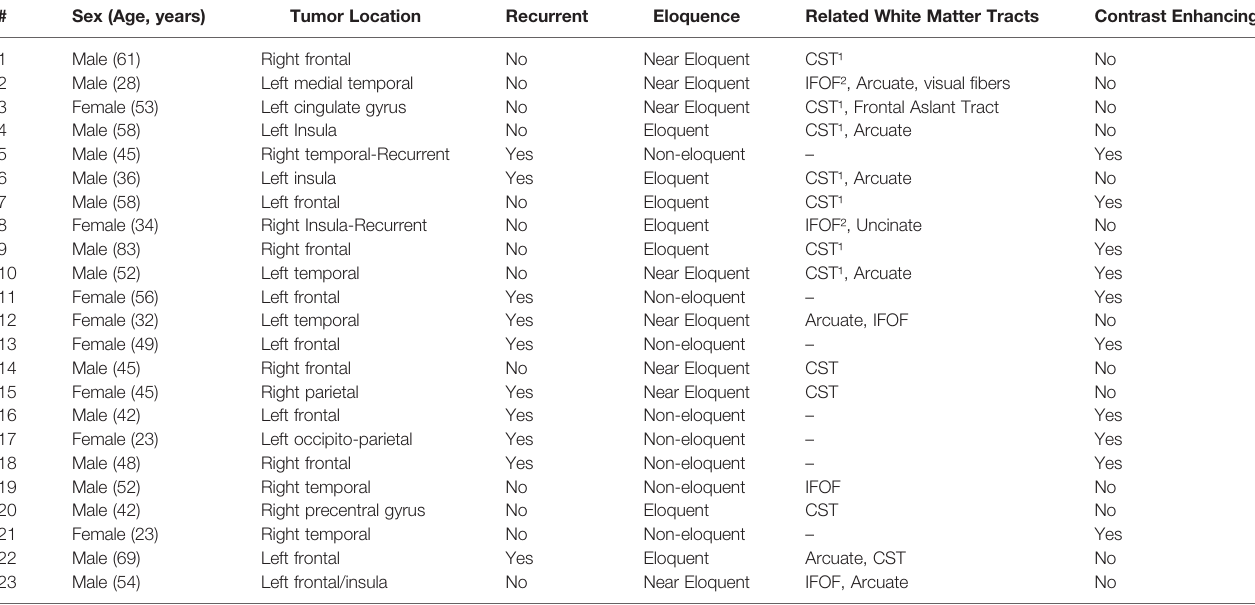
TABLE 1 | Summary of patient demographics, and preoperative clinical and radiological aspects of brain